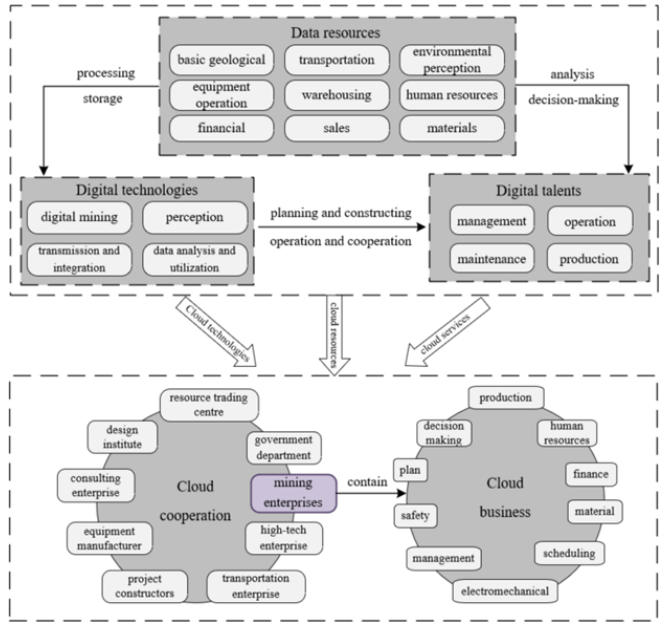
Figure 1. The logical relationship between elements of the CM mode: Specifically, data resources include all aspects of mining operations. Digital technologies are the main tool for generating, transmitting, integrating, processing, and analyzing data resources. Digital talents can use the analysis of data resources to help decision-making, and use digital technologies to complete various tasks. Under the CM mode, the businesses of mining enterprises are carried out on the cloud, and enterprises collaborate on the